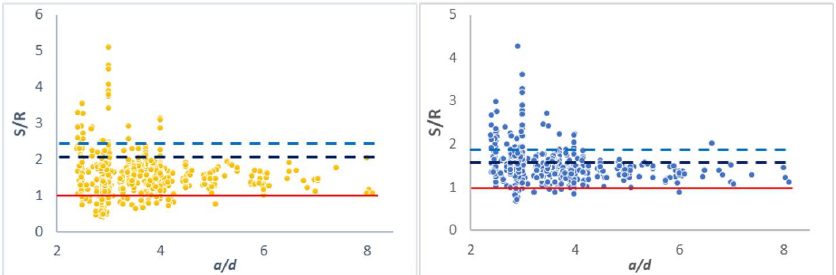
Figure 5 - S/R in relation to